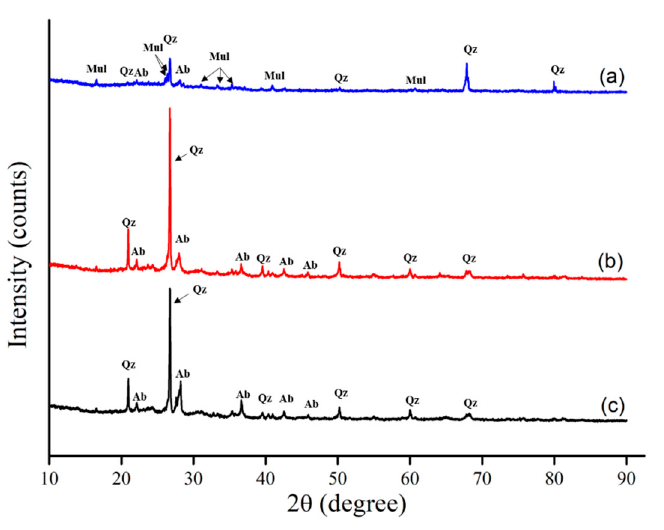
Figure 2. XRD analysis ( a ) BA, ( b ) SBA, ( c ) SMBA (A, M, and Q represents albite, mullite, and quartz).